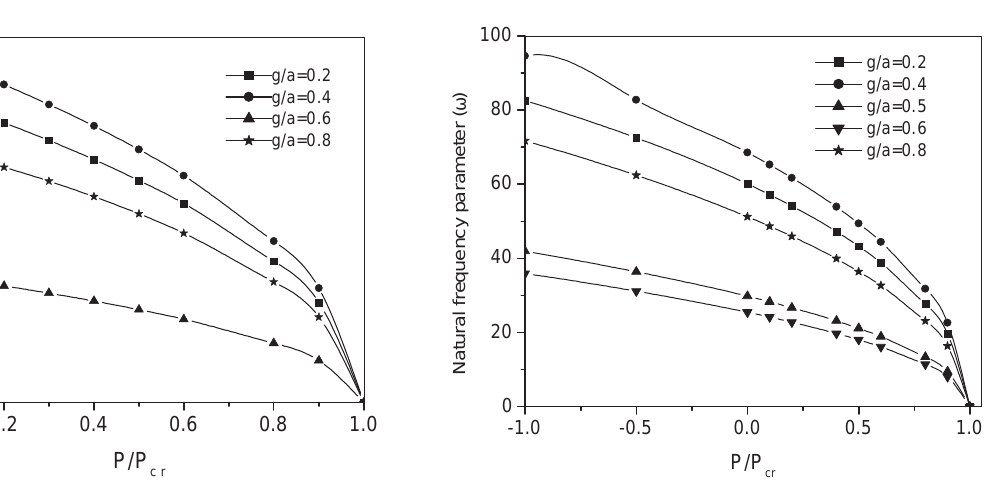
Fig. 14. As Fig. 12, but for bi-axial compressive forces.